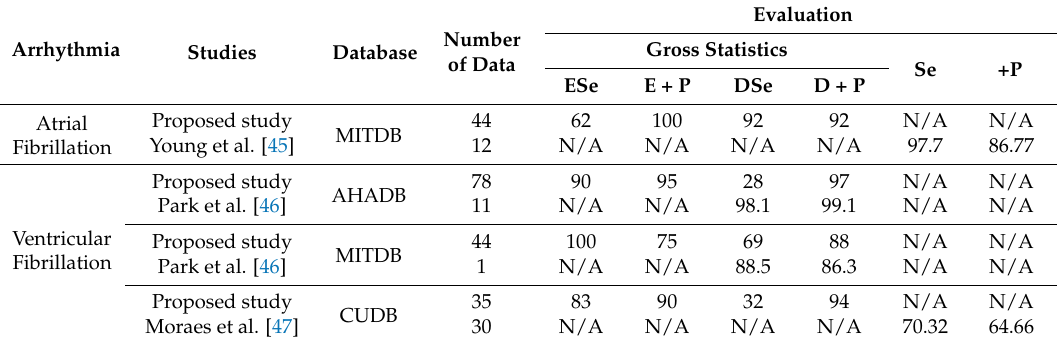
Table 5. The AF and VF result comparison. (N/A = not